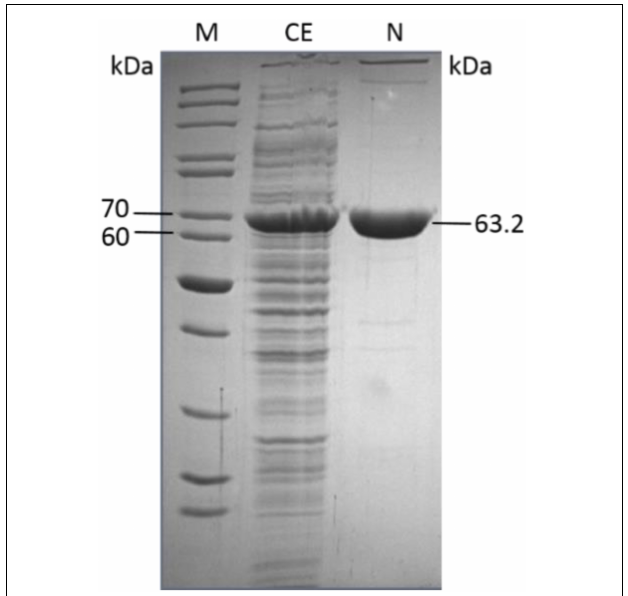
FIGURE 2 | One-step pruification of the recombinant Caulobacter crescentus EDD from transformed E . coli BL21(DE3) as analyzed by SDS-PAGE (M, molecular weight marker PageRuler Thermo Scientific/Fermentas; CE, crude extract; N, purified Cc EDD after